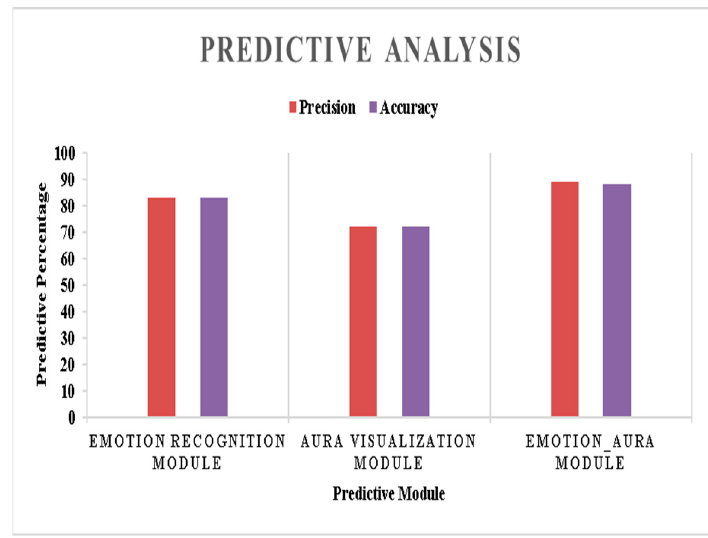
Figure 10. Comparative analysis of the modules.